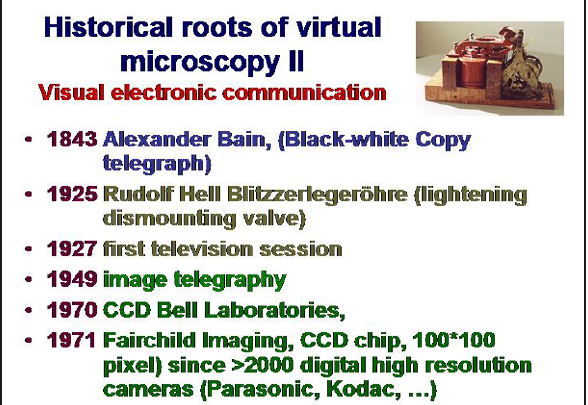
Figure 2 Historical roots of virtual microscopy related to visual electronic communication .